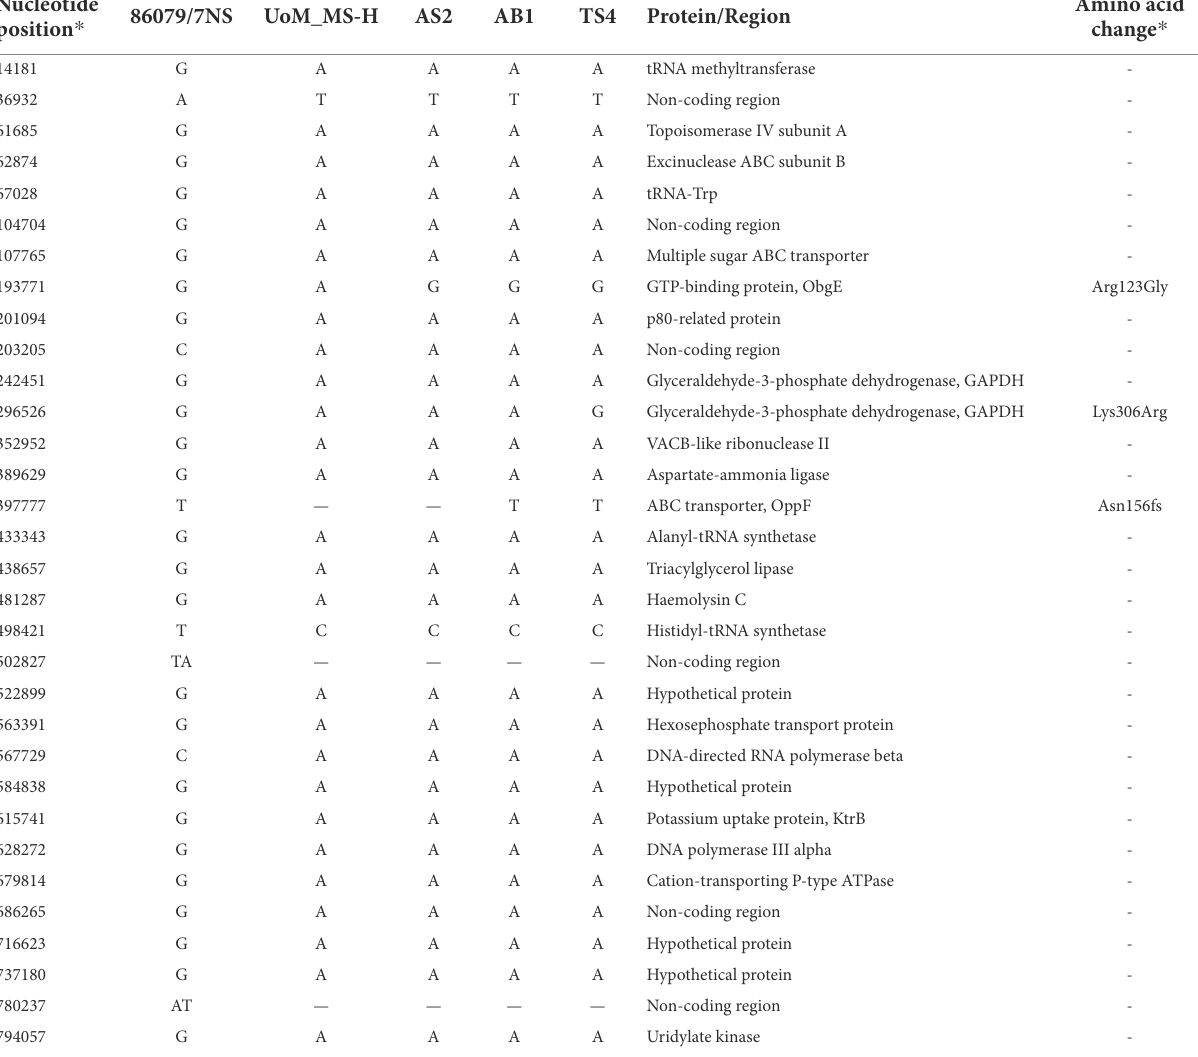
TABLE 1 Comparison of genome sequences of the MS-H reisolates to those of MS-H and 7NS (excluding the repetitive and variable regions). Nucleotide position *